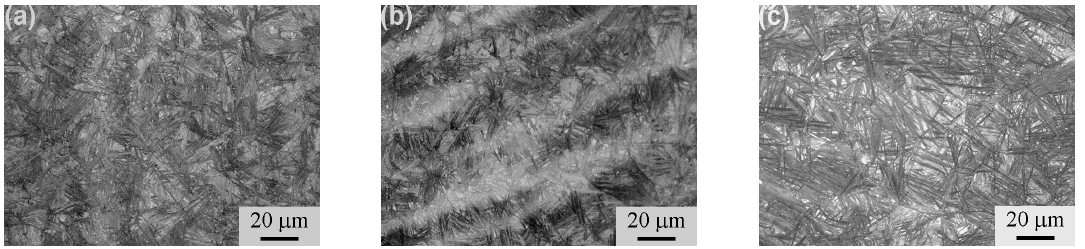
Figure 2. OM micrographs of isothermally-transformed samples. ( a ) A1; ( b ) A2; ( c ) A3.